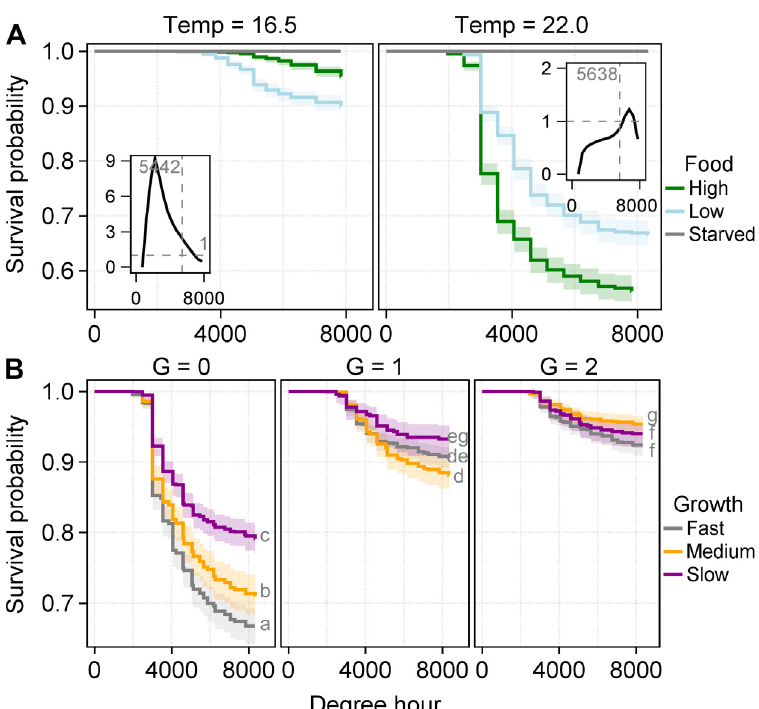
Fig. 4. Survival probability of oysters exposed to OsHV-1 for the effects used in the Cox regression model: (A) temperature × food and (B) line × growth. Insets show odds ratios of low vs. high food level as a function of time for each tem- perature. Vertical reference line indicates the time when the risks between food levels are equal. Values are means ± 95% confidence intervals. Lower- case letters indicate significant differences. G: